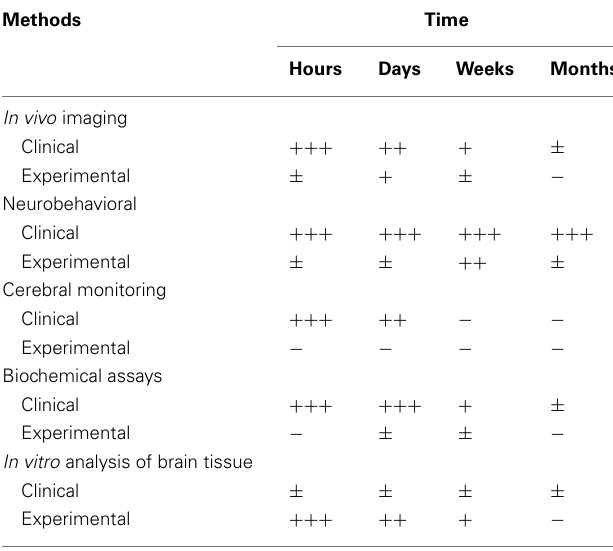
Table 3 | Comparing the temporal pattern of performing the various analyses in clinical and in experimentalTBI